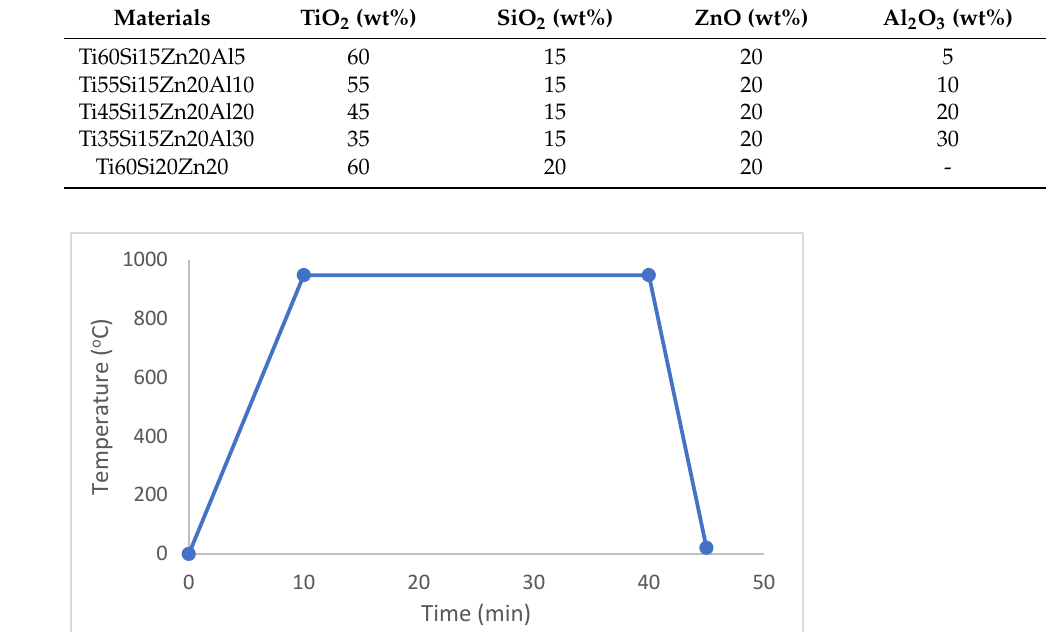
Table 1. wt% of materials used in production.